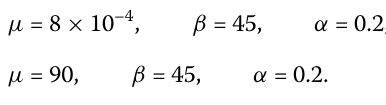
the initial conditions are taken at (0.4,5.5) and (0.2,6). As we can see in this figure, the equilibrium ( u ∗ , v ∗ ) is unstable and the solution goes to a stable limit